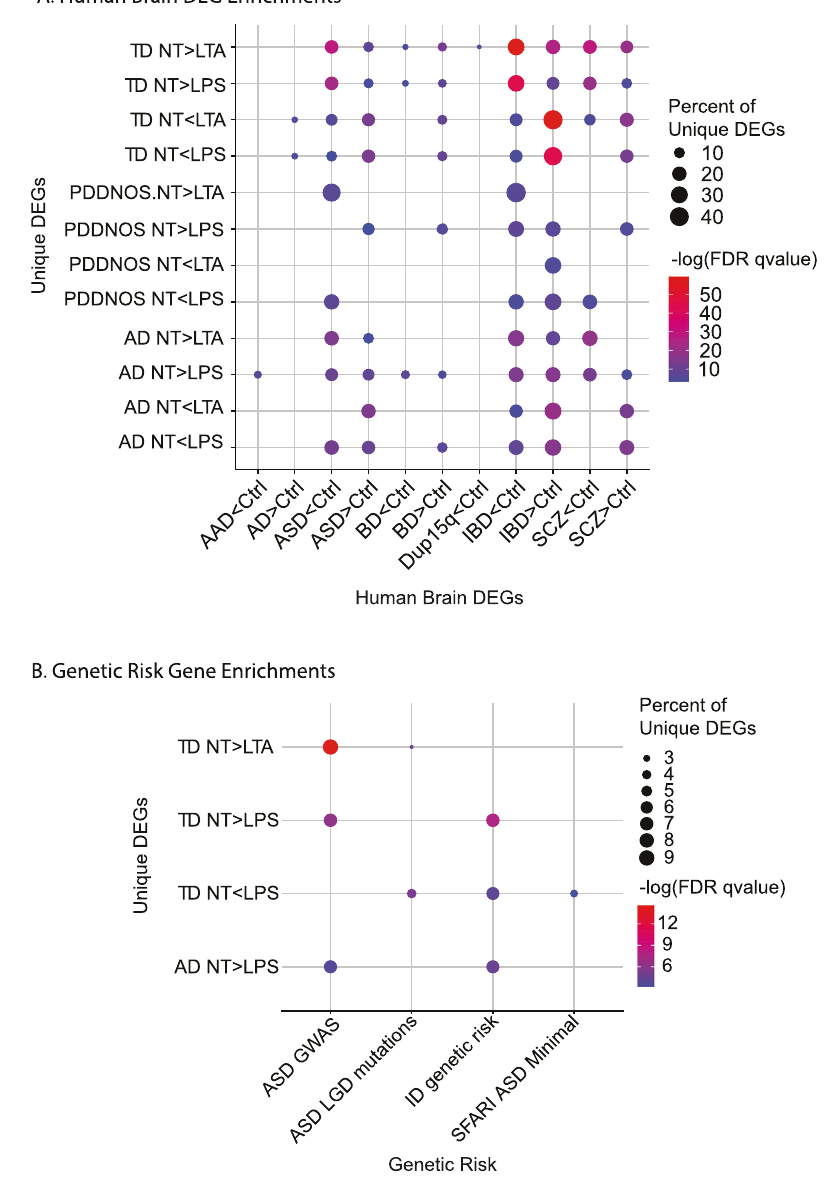
Fig. 4 Monocyte stimulated DEGs are enriched for DEGs and genetic risk genes for human brain disorders. A Signi fi cant enrichments for the overlap between DEGs identi fi ed in this study (rows) and published gene lists for DEGS (columns) identi fi ed in human brain for neuropsychiatric and neurodevelopmental disorders. Signi fi cant enrichments are colored by -log(FDR qvalues) and the percent of unique DEGS shared between the two lists is represented by dot size. BD: bipolar disorder, SCZ: Schizophrenia, AD: Alzheimer ’ s disease, IBD: in fl ammatory bowel disease, AAD: alcoholism, Dup15q: duplication 15q syndrome. Gene lists, citations and statistics are in Table S9. B Signi fi cant enrichments for the overlap between DEGs identi fi ed in this study (rows) and published risk genes for ASD and ID (columns). Signi fi cant enrichments are colored by -log(FDR qvalues) and the percent of unique DEGs shared between the two lists is listed in each block. Gene lists, citations and statistics are in Table